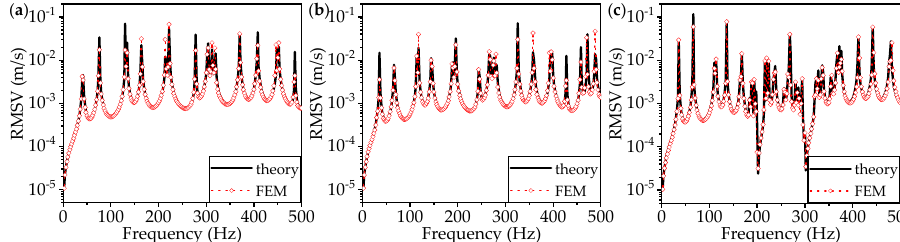
Figure 5. The comparison between the root-mean-square velocities (RMSVs) averaged over the whole surface calculated by the theory and finite element method (FEM) for ( a ) the bare plate, ( b ) the mass-loaded plate, and ( c ) the locally resonant plate.